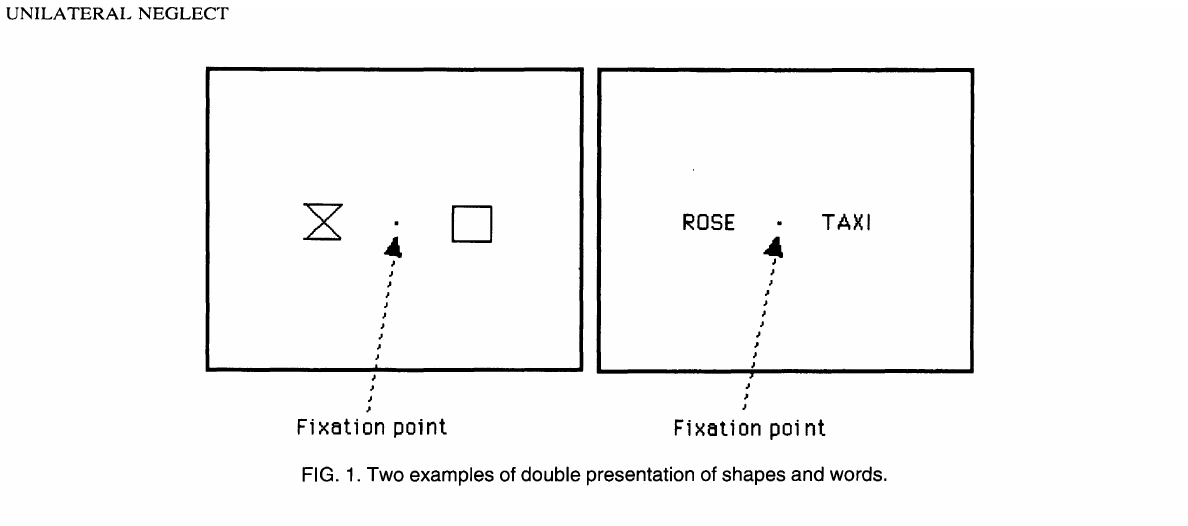
FIG. 1. Two examples of double presentation of shapes and